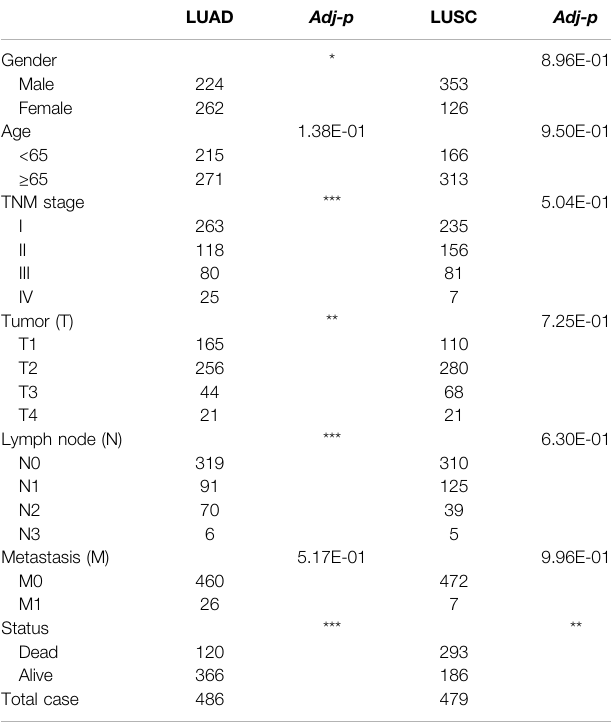
TABLE3| ClinicopathologicalfeaturesfromLUADandLUSCsubgroupsstrati fi ed by the AS events signature.